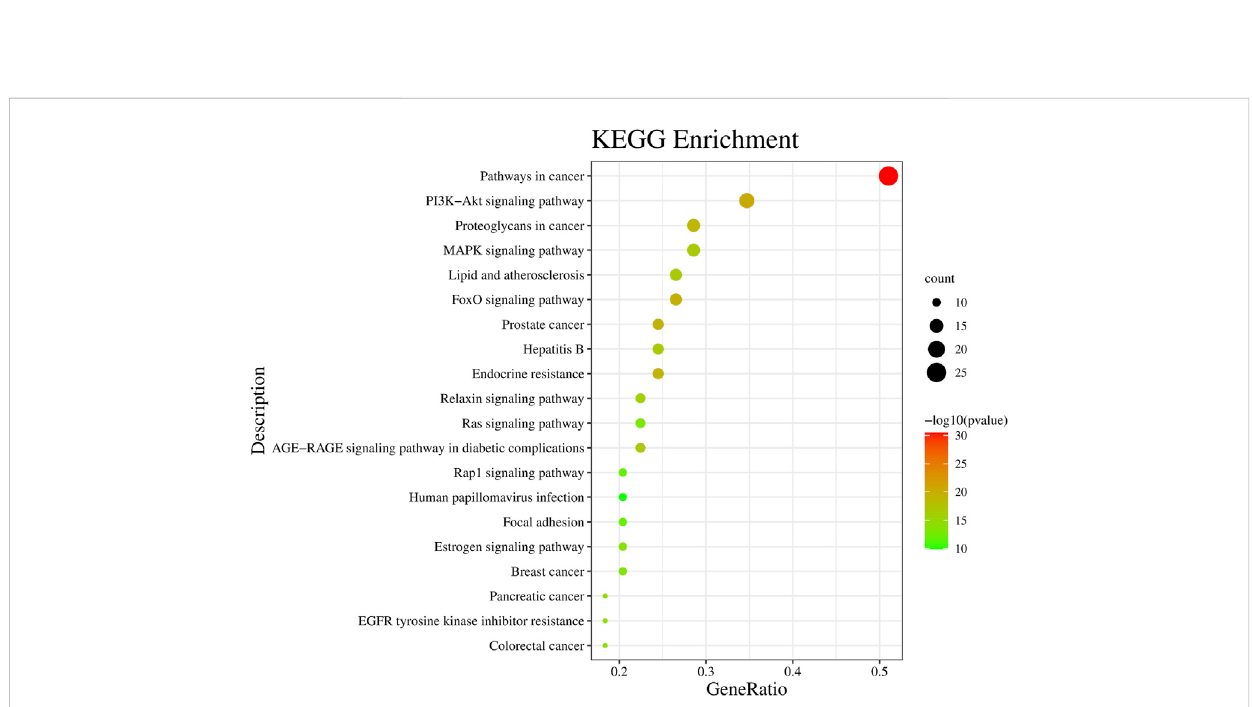
FIGURE 4 Kyoto Encyclopedia of Genes and Genomes (KEGG) signaling pathway enrichment analysis. Bubble color and size distribution represent − logP values and the number of genes involved in this signaling pathway,